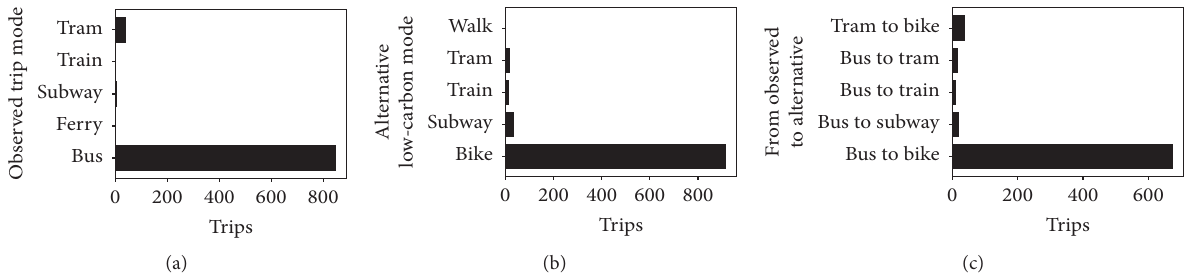
Figure 27: Distribution of the noncar trips that have low-carbon time-relevant alternatives, together with distribution of their low-carbon alternatives.